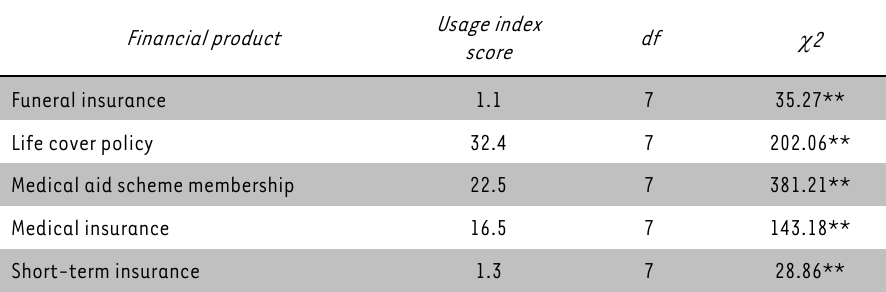
TABLE 4: Precautionary